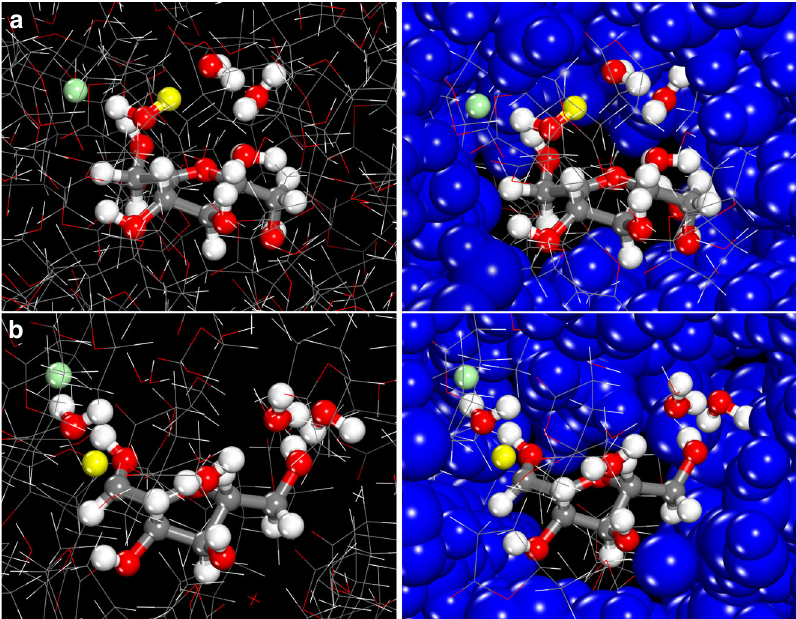
Fig. 5 Structures representing solvation by Cl − of transition states in 90% GVL/10% H 2 O (w/w). a The protonation of the C2 hydroxyl and the elimination of water to form the oxocarbenium ion and ( b ) the deprotonation of the oxocarbenium ion to form the enol. The Cl − (green sphere) in both transition state structures directly interacts with the active protons (yellow sphere) and resides in the hydrophilic shell that surrounds fructose. The active hydrophilic cavity which is shown via the ball-and-stick structures is encapsulated by the hydrophobic shell comprising GVL. The structures on the left-hand side show the hydrophobic outer shell via simple stick fi gures, whereas those on the right-hand side depict the atoms in the hydrophobic shell as CPK structures to better highlight the inner hydrophilic cavity and the outer hydrophobic shell. The high concentration of GVL localizes the H + and Cl − ions at the active site, enabling Cl − to promote the reaction. The structures of transition states for fructose dehydration carried out in 90% GVL/10% H 2 O